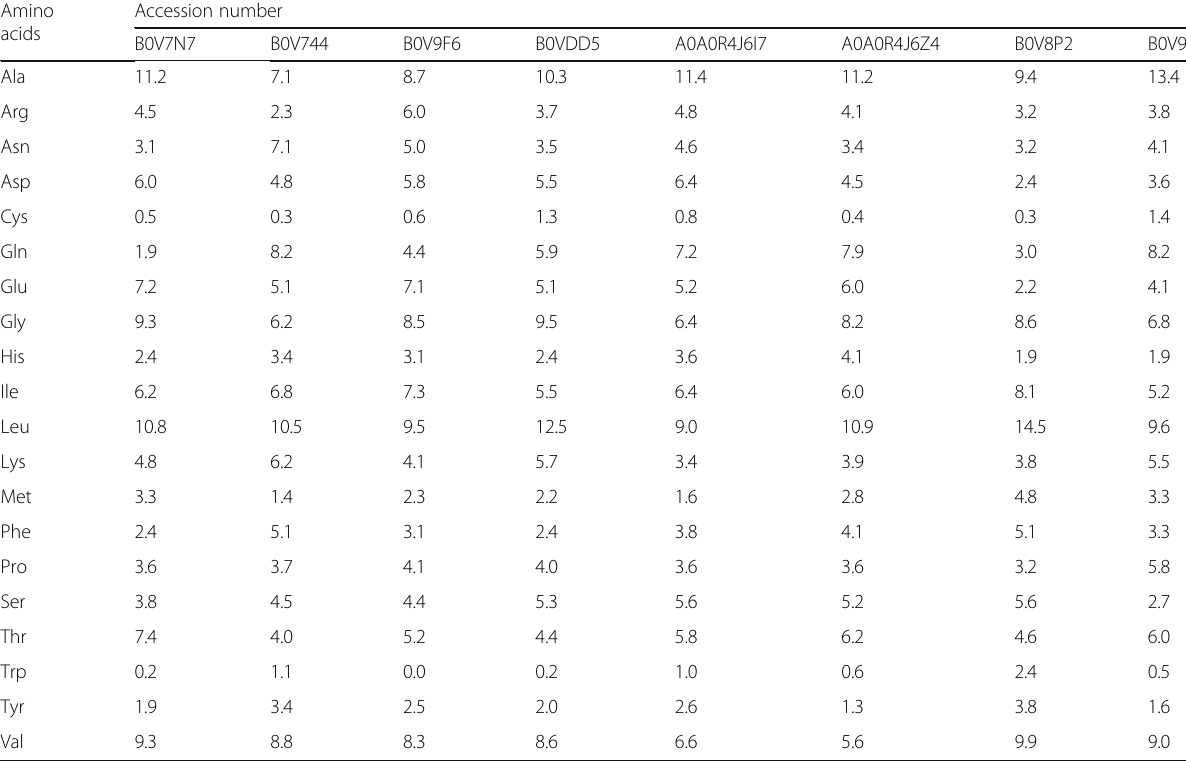
Table 3 Amino acid composition (in %) of eight Mur family proteins from A . baumannii Amino acids